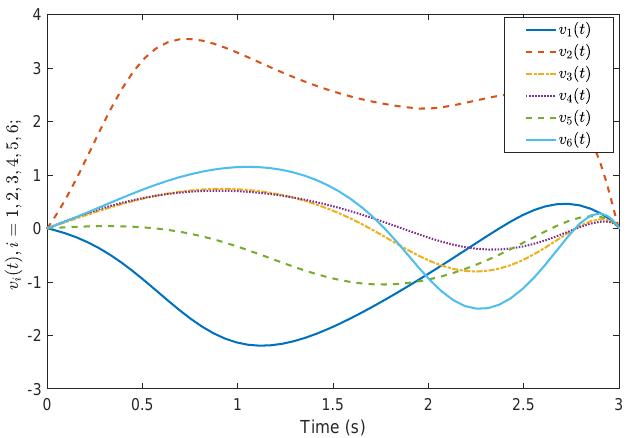
Figure 9. Velocity states v (t) by the prescribed-time Controller (62).